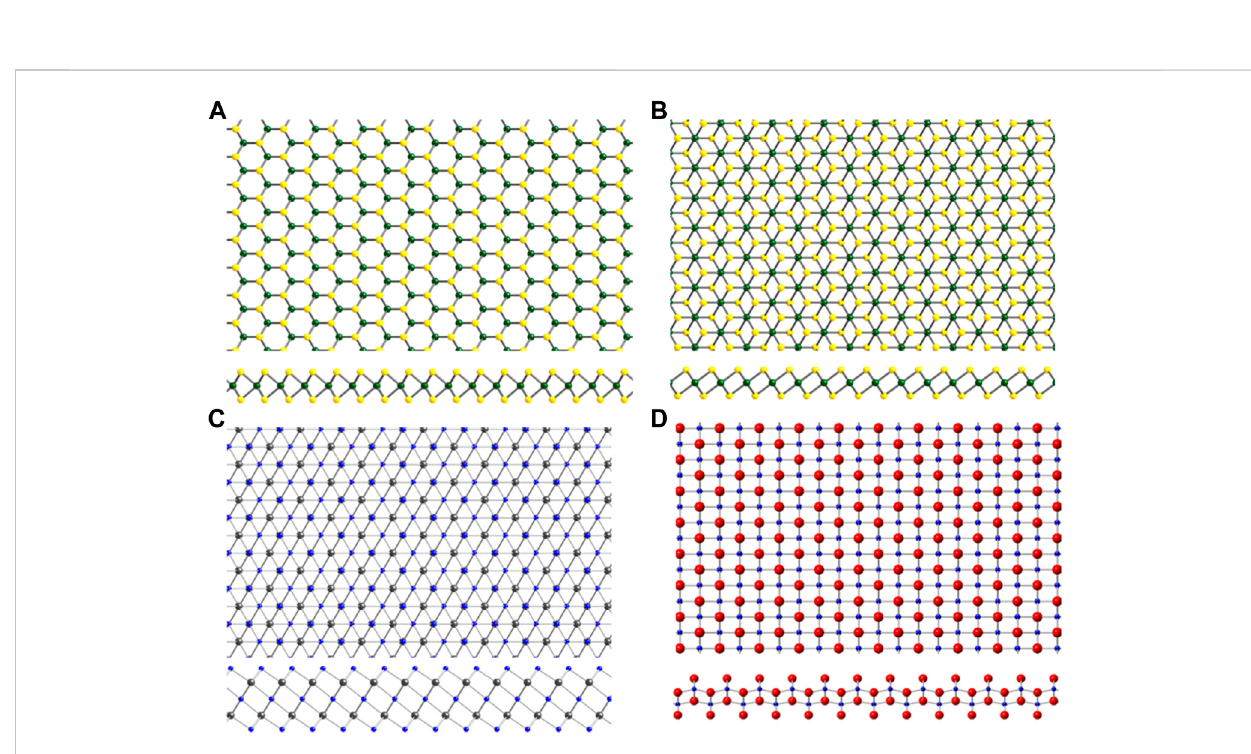
FIGURE 3 Structures of 2D materials that were discovered or have attracted renewed interest after the isolation of graphene. (A) Transition metal dichalcogenide (TMD) 2H crystal structure and (B) TMD 1T crystal structure. Here, transition metal atoms are shown in green, and chalcogen atoms shown in yellow. (C) Ti 3 C 2 crystal structure representative of the MXene family. (D) 2D transition metal oxide Ti 0.91 O 2 0.36- . Ti shown in blue, C in grey, O in